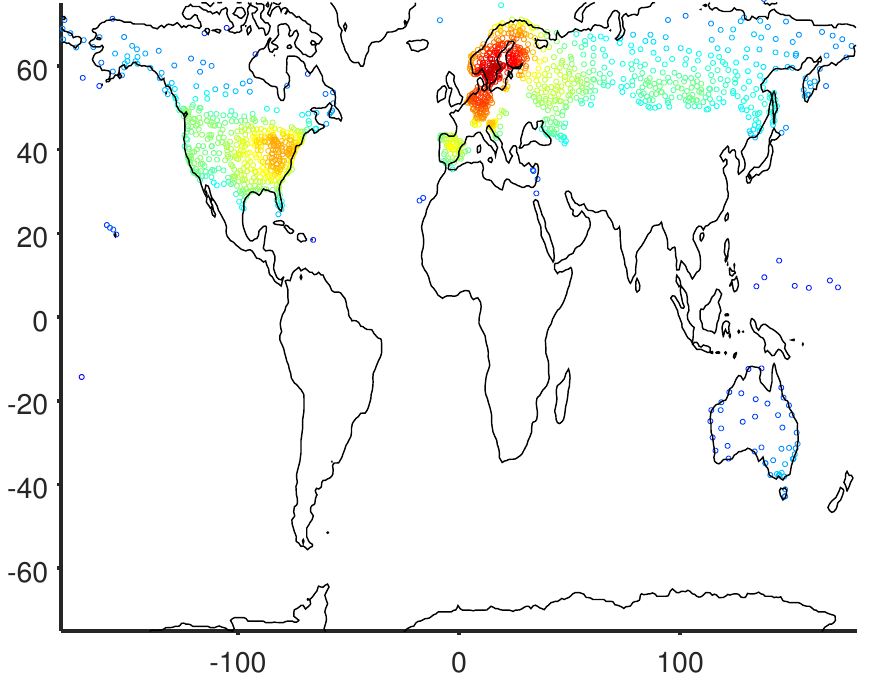
Figure 1. Locations of Daily Global Historical Climatology Network (GHCN-Daily) stations used. ‘Hotter’ marker colors denote locally higher station